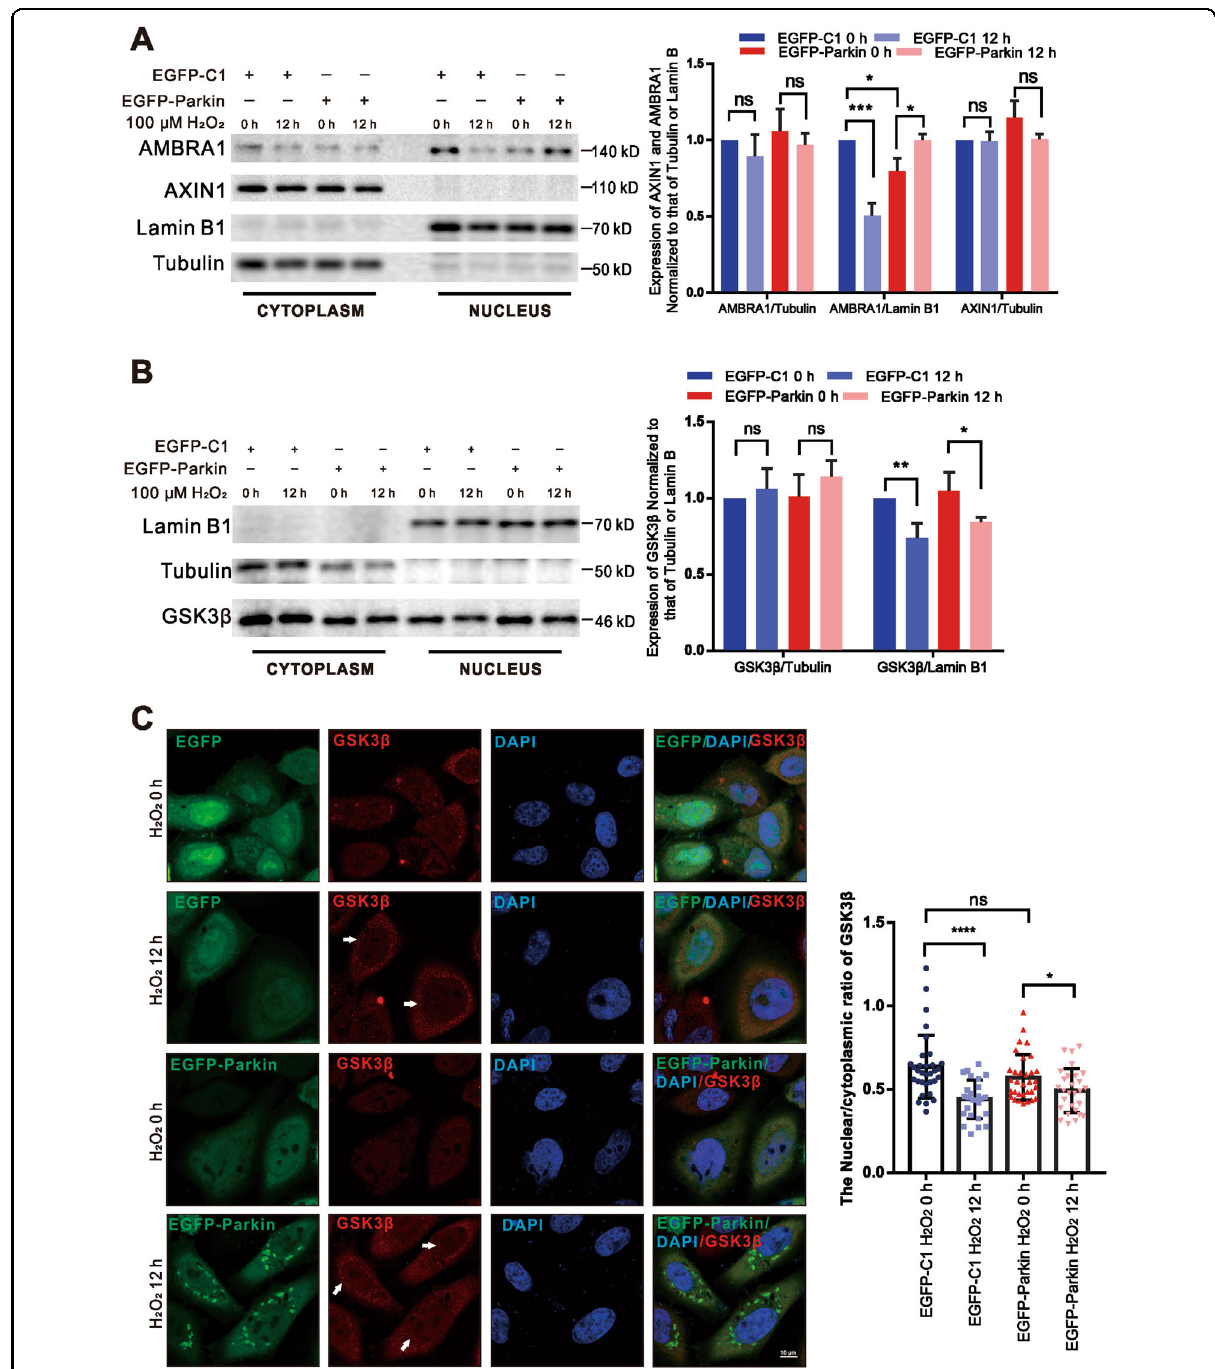
Fig. 5 H 2 O 2 stimulation promotes the expression of c-Myc by decreasing GSK3 β levels in the nucleus. A , B Cells were transfected with EGFP- C1 or EGFP-Parkin and then stimulated with 100 μΜ H 2 O 2 for 0 h or 12 h. Then, nuclear and cytoplasmic proteins were isolated for WB analysis. The protein levels were analyzed with the indicated antibodies. N = 3; ns, not signi fi cant; * P < 0.05; ** P < 0.01; *** P < 0.001. The data are from three independent tests and are presented as the mean ± SD. C Cells transfected with EGFP-C1 (green) or EGFP-Parkin (green) were incubated with 100 μΜ H 2 O 2 for 0 h or 12 h. The cells were immunostained with an anti-GSK3 β antibody (red). The white arrows show GSK3 β in the nucleus. The fl uorescence intensity was analyzed with ImageJ, and the data were subjected to statistical analysis (~30 cells for each analysis). Scale bars, 10 μ m. Ns, not signi fi cant; * P < 0.05; **** P <